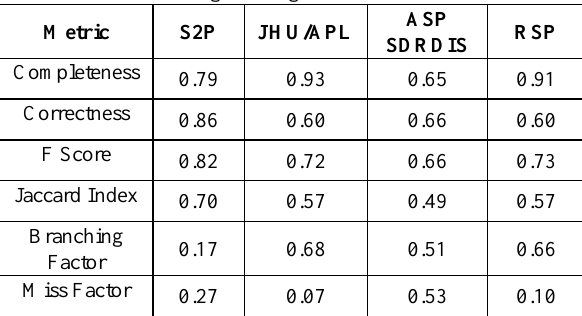
Table 4 2D building labeling metrics for MVS